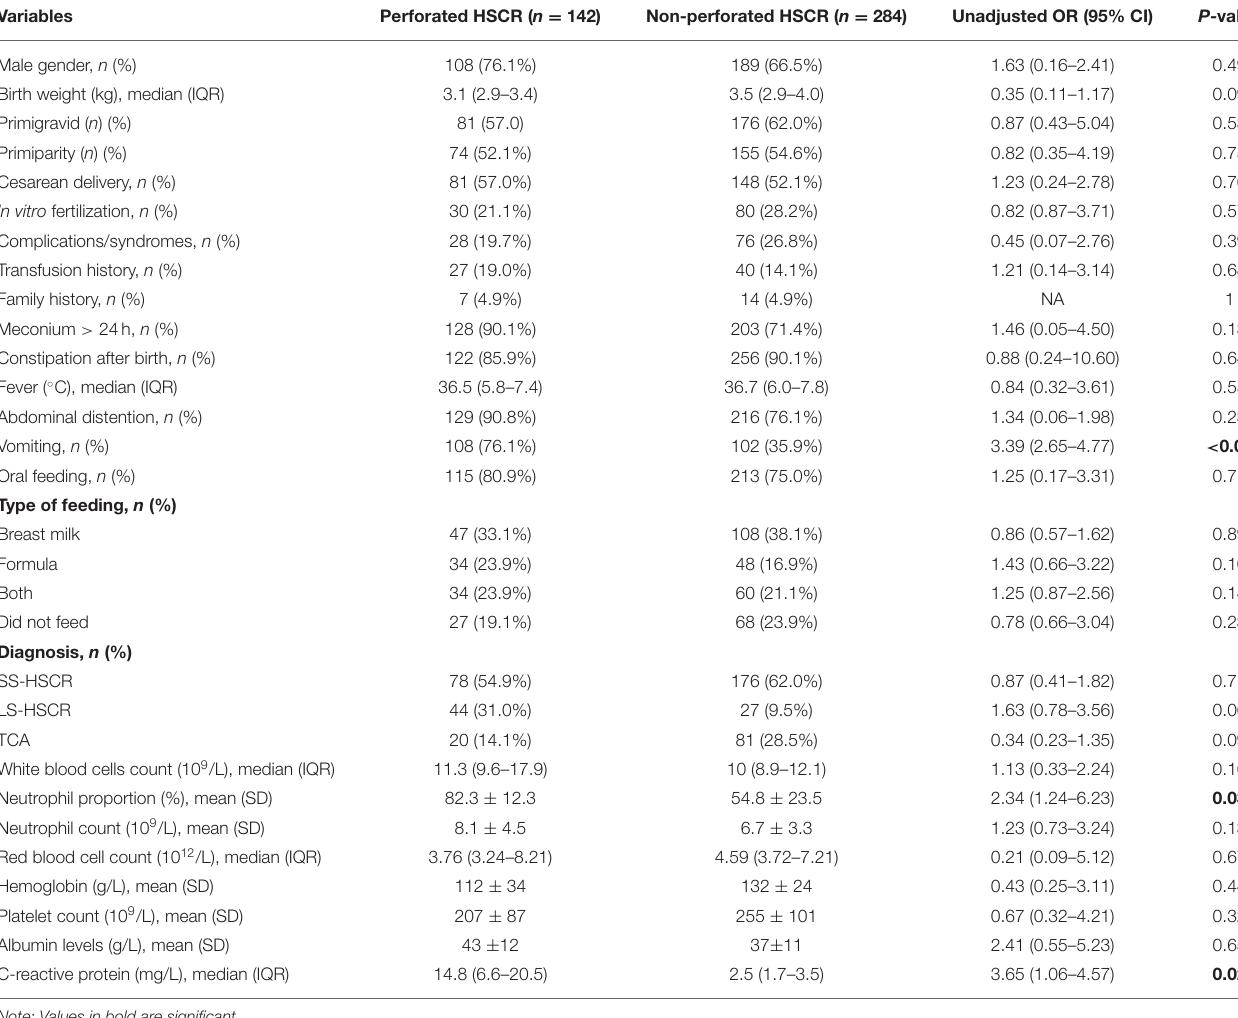
TABLE 2 | A comparison of risk factors for HD bowel perforation in neonates and control subjects. Variables Perforated HSCR ( n = 142) Non-perforated HSCR ( n = 284) Unadjusted OR (95% CI) P -value